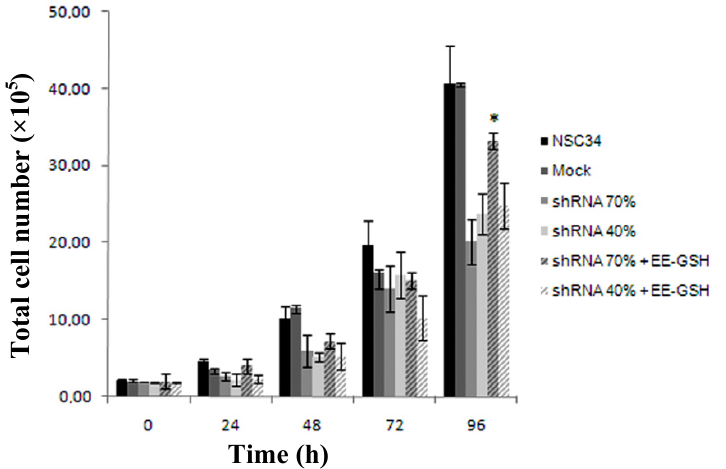
Figure 7. Effect of EE-GSH on cell proliferation of frataxin-silenced NSC34. After incubating cells with 500 μ M EE-GSH, cell proliferation was evaluated by trypan blue exclusion assay. The data were expressed as the number of cells that excluded the dye. Results represent the mean of three independent determinations repeated four times. * p <